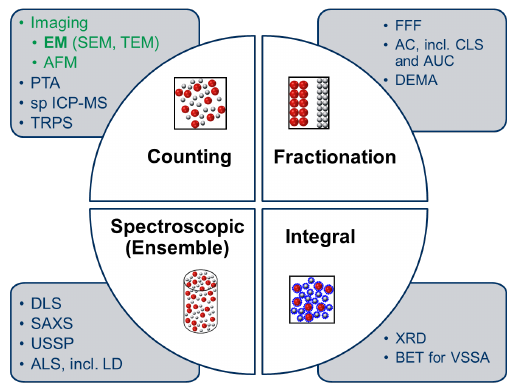
Figure 1. Overview of the measurement techniques (MTs) systematically characterized in the NanoDefine project and included into the NanoDefiner framework. Tier 1 MTs are marked dark blue, Tier 2 MTs are marked green. Displayed acronyms are explained in the text as well as in Table